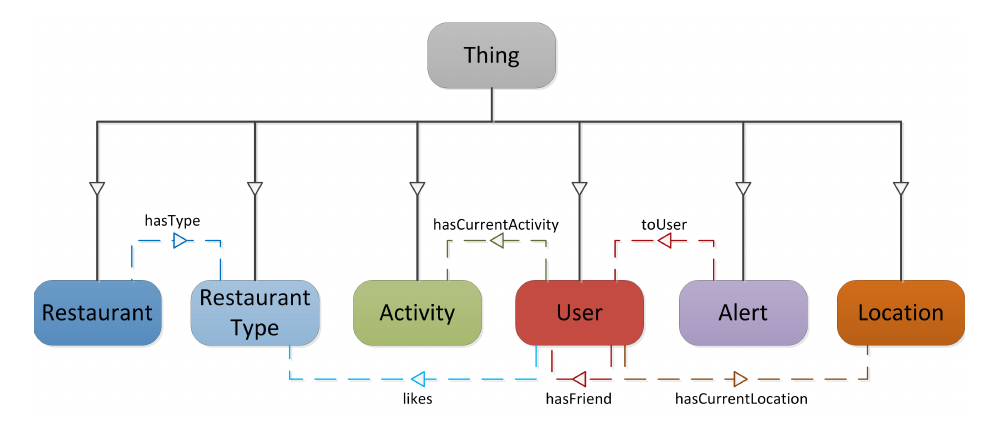
Figure 3. General Ontology.